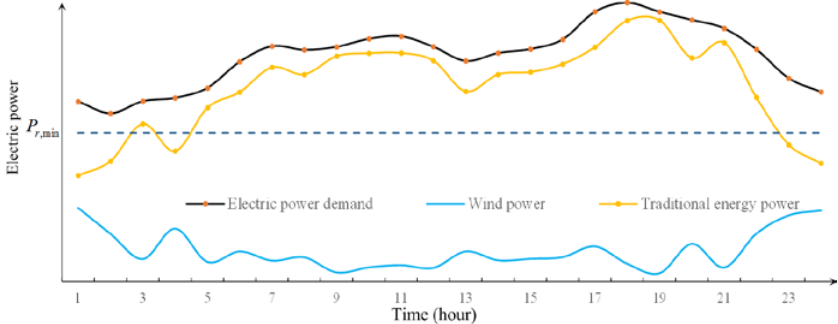
Figure 2. A sketch map of reverse peak regulation characteristics of wind